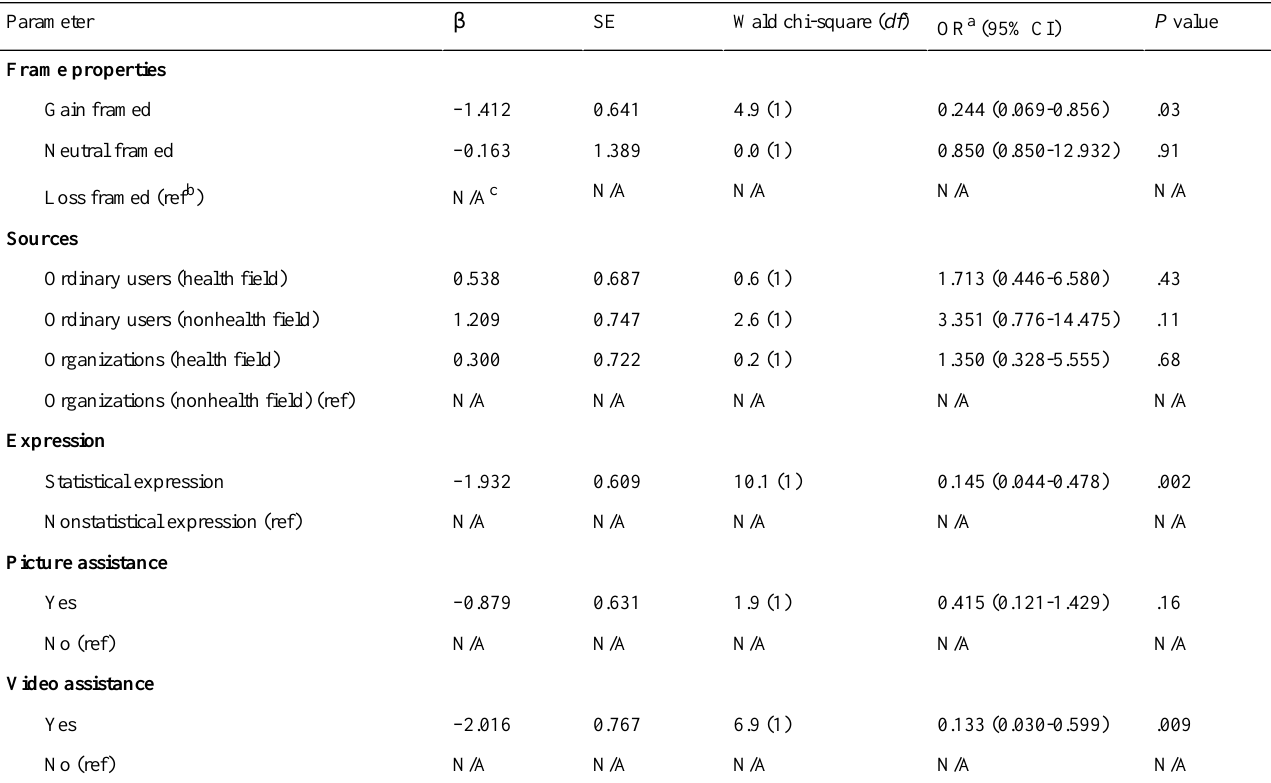
Table 3. Binary logistic regression for health-promoting messages regarding